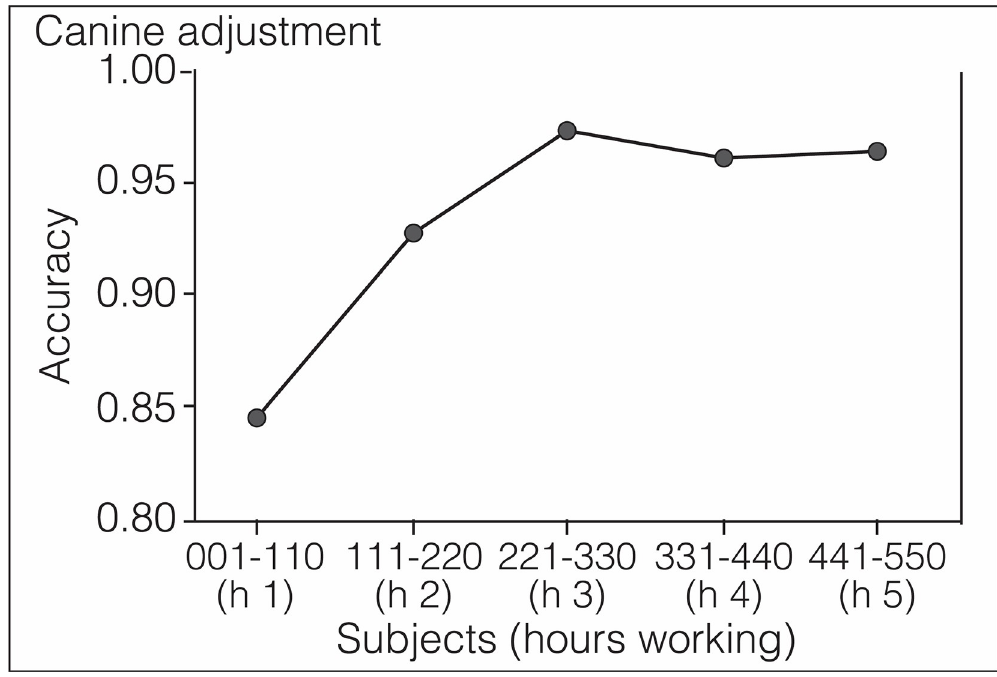
Fig 7. Phase 4: In vivo screening (effectiveness assay). Canine adjustment to a real-life situation. Accuracy started much lower under real-life conditions, but improved with time as the dogs adjusted to the new environment. Numbers labeling the abscissa represent the order in which subjects were screened by the dogs, divided in groups of 110 individuals. Screening each group took approximately one hour of work for the